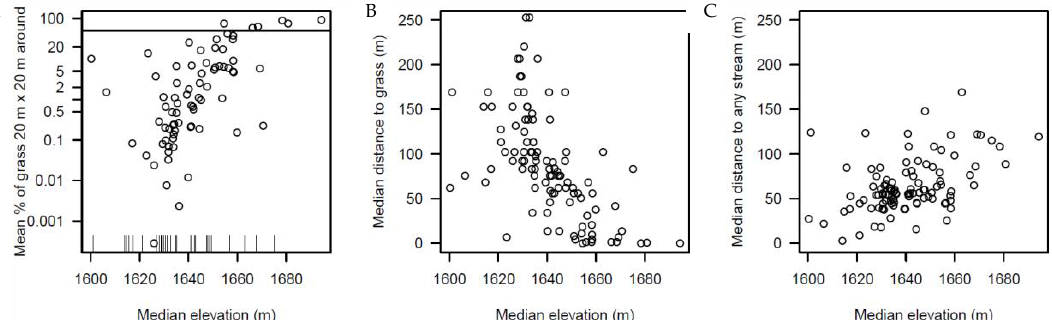
Figure 5. Environmental preferences of species in the Ngel Nyaki plot. Each point in the figure represents one species. ( A ) Median elevation of the individuals of each species vs. the mean % of grass pixels in a 20 × 20 m window around each individual of the species ( r = 0.57). The vertical axis is in logarithmic scale; ticks in the horizontal axis represent species that have absolutely no grass around (zeroes cannot be represented in the logarithmic scale). The horizontal line at 50% separates four savannah species and two species from the rest. ( B ) Median elevation vs. median distance to the grass across all the individuals of each species ( r = − 0.60). ( C ) Median elevation vs. median distance to the closest stream across all the individuals of each species ( r = 0.45).